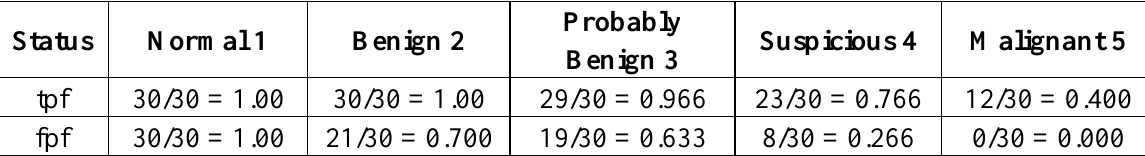
Table 7. TPF versus FPF for Mammography.